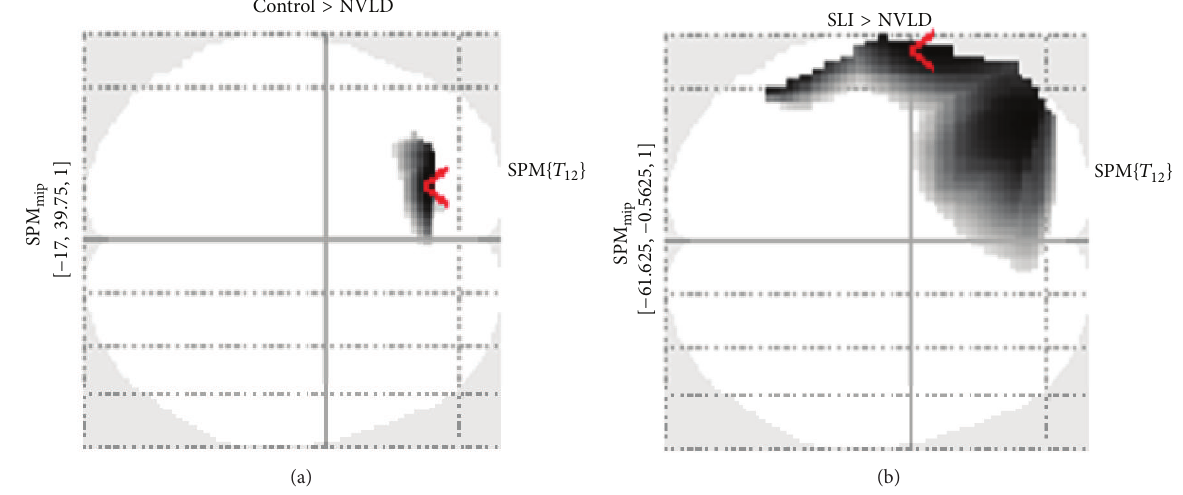
Figure 12: SPM contrasts for the congruency effect within abstract trials, in the two clinical groups.